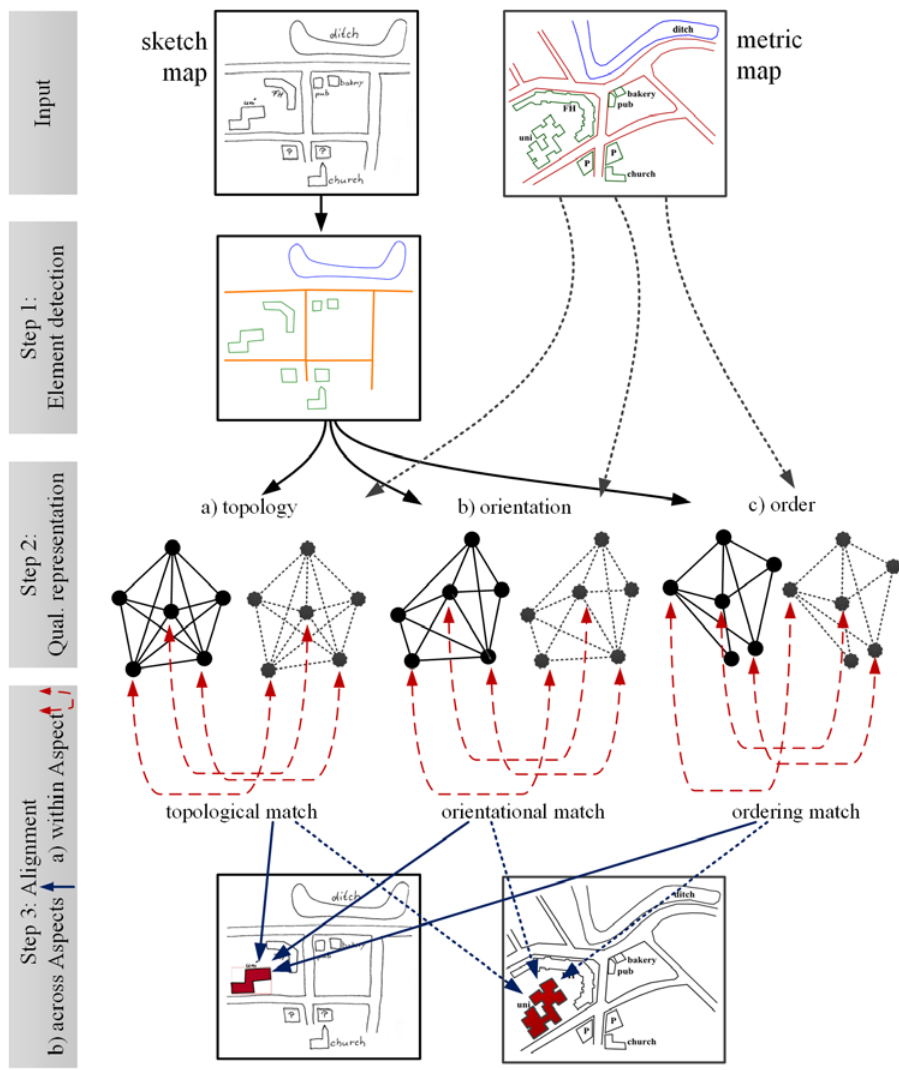
Figure 1: Shows the structure of the framework (source: [38]). The workflow of the system comprises 3 main steps extracting elements from sketch map (step 1), qualitative represen- tation of the input maps (step 2), and qualitative alignment of maps (step 3).